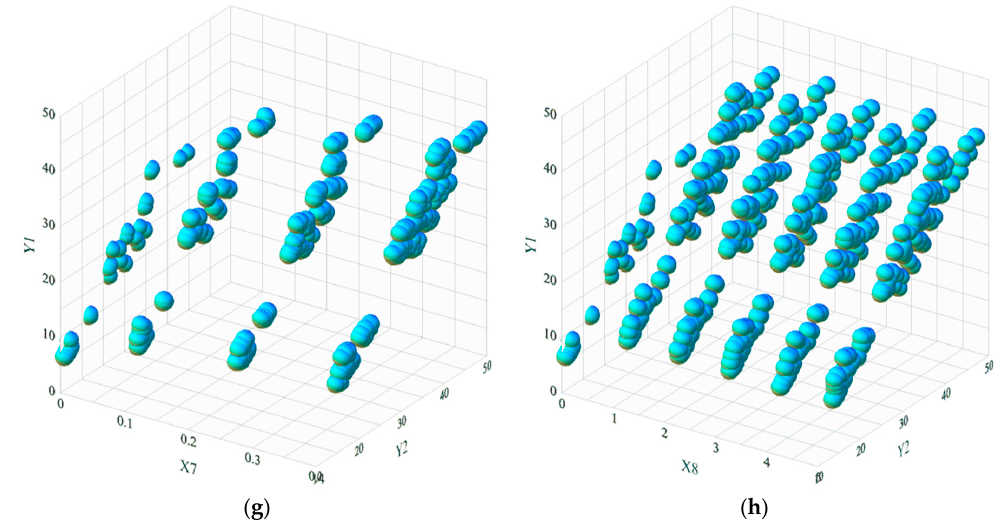
Figure 5. The spatial distribution of the X1 ( a ), X2 ( b ), X3 ( c ), X4 ( d ), X5 ( e ), X6 ( f ), X7 ( g ), X8 ( h ), against the heating load (HL) and cooling load (CL).